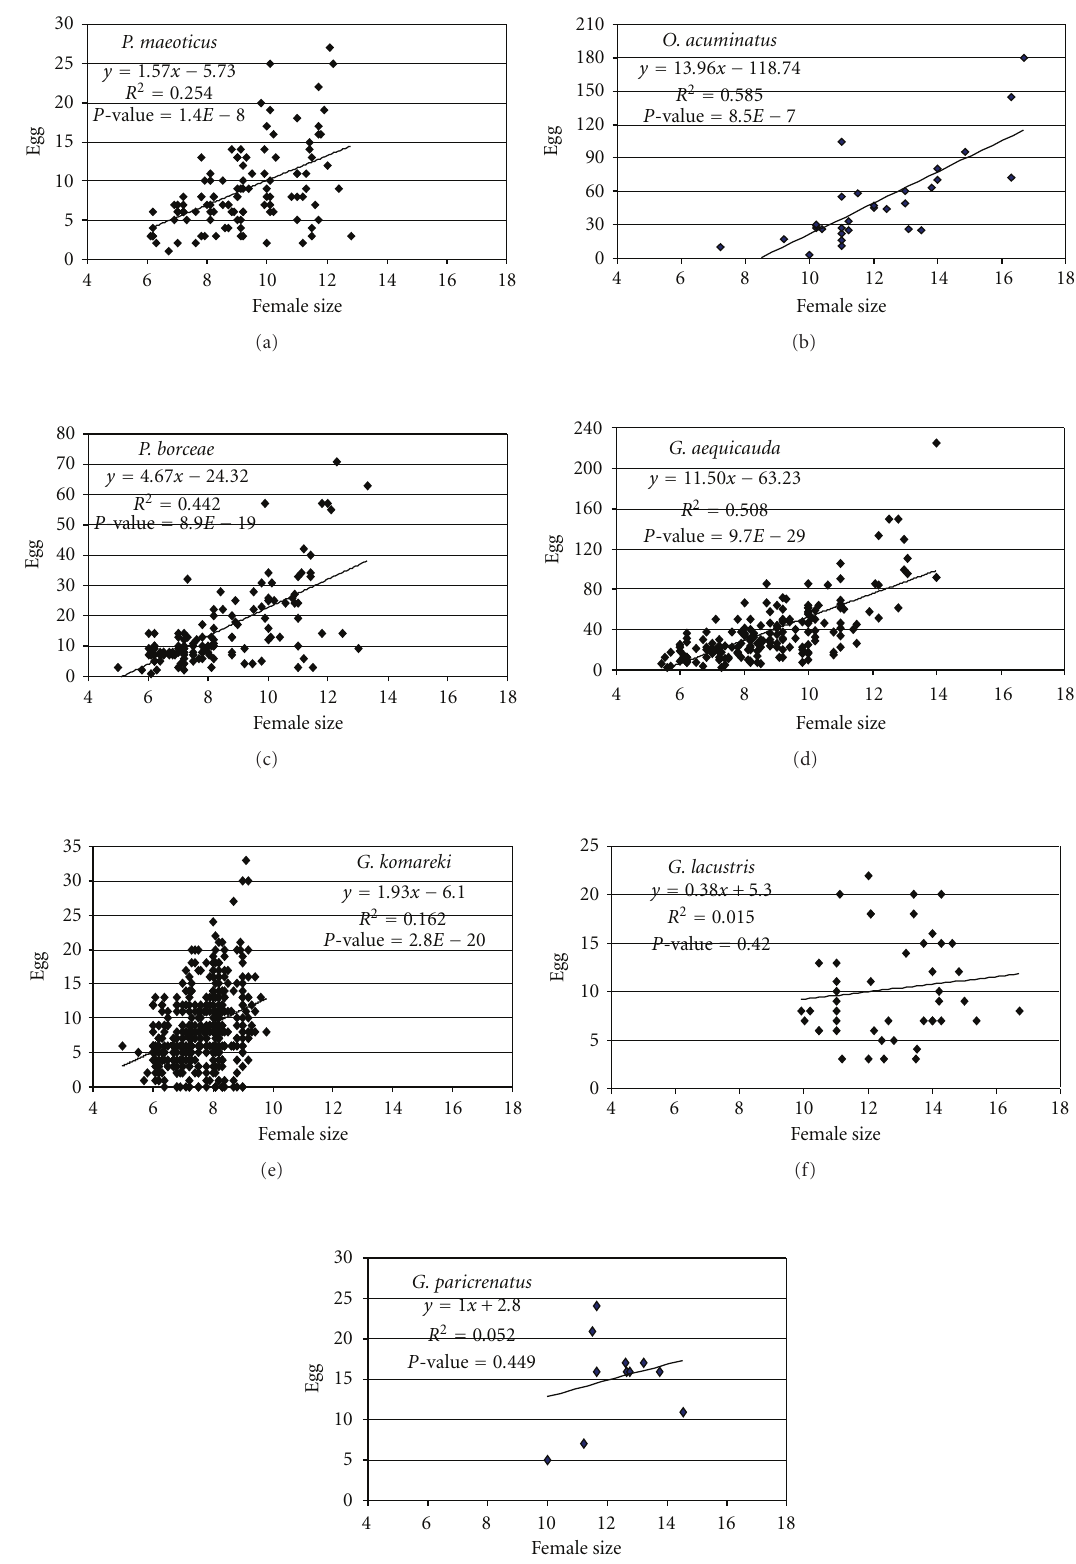
Figure 5: Linear regression of egg number in brood pouch with female size for each